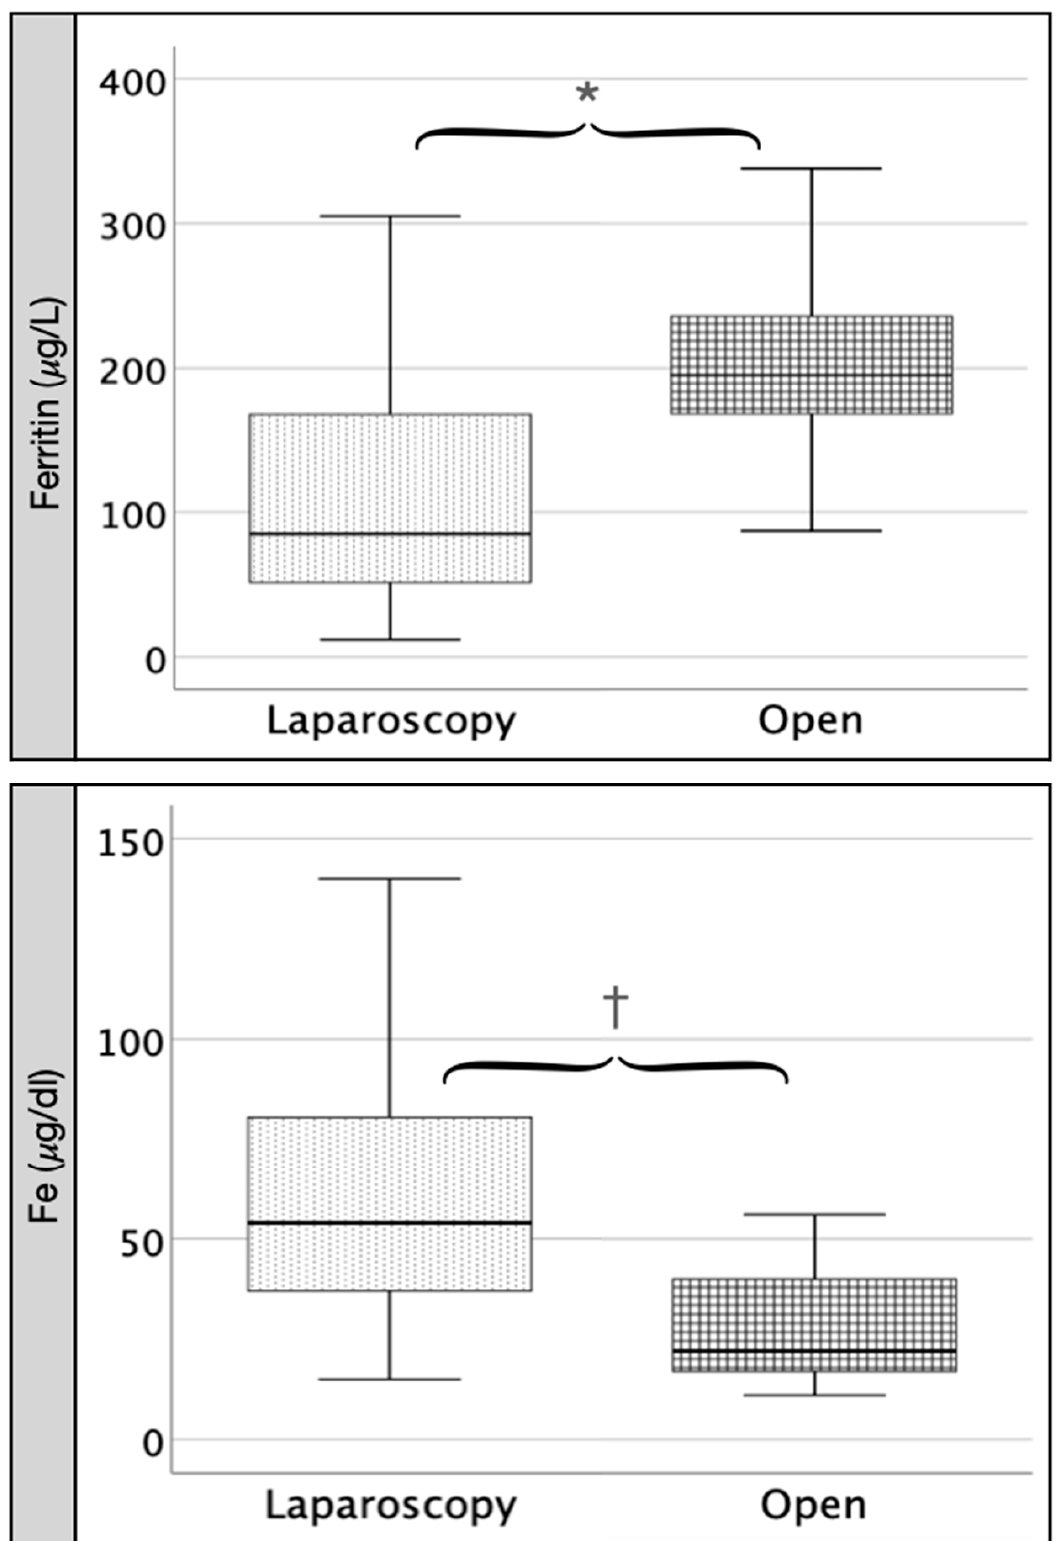
Figure 4. Comparison between LC and OC at postoperative day 1 (A2): ferritin and Fe. Legend: Comparing open (OC) versus laparoscopy (LC) group 24 h after surgery (A2), we find a significant increase in ferritin in OC ( ∗ = 0.01) and a significant decrease in Fe in OC († = 0.01).